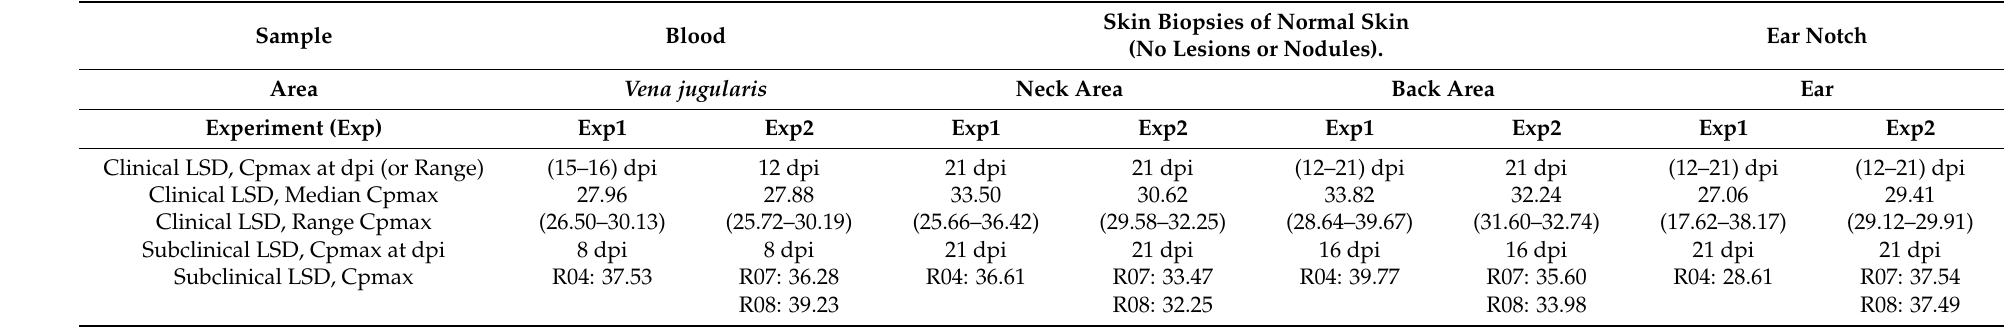
Table 2. The results of the real-time PCR for the blood, skin and ear notch samples taken in experiment 1 and 2, and given as the median and range of the maximum Cp values for the clinically infected animals and as the maximum Cp values for the subclinically infected